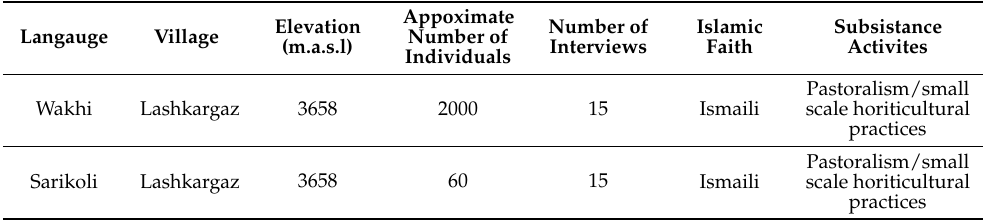
Table 1. Characteritics of the studied